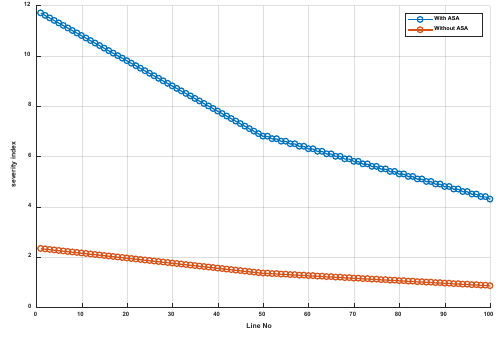
Figure 11. Analysis of Severity index